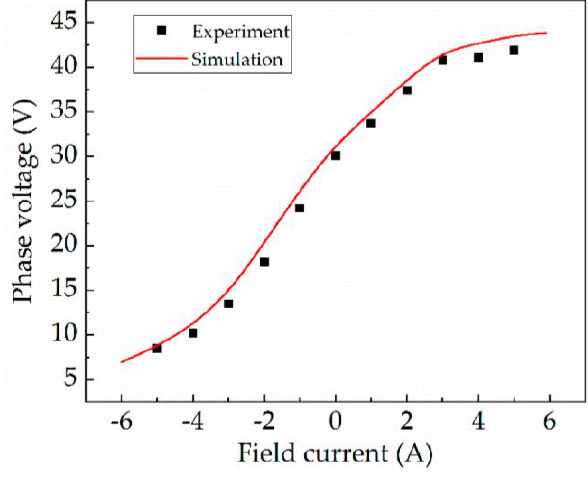
Figure 2. Presented as Figure 14 in [2]. Figure 14. No-load characteristics: ( a ) flux regulation capac- ity .